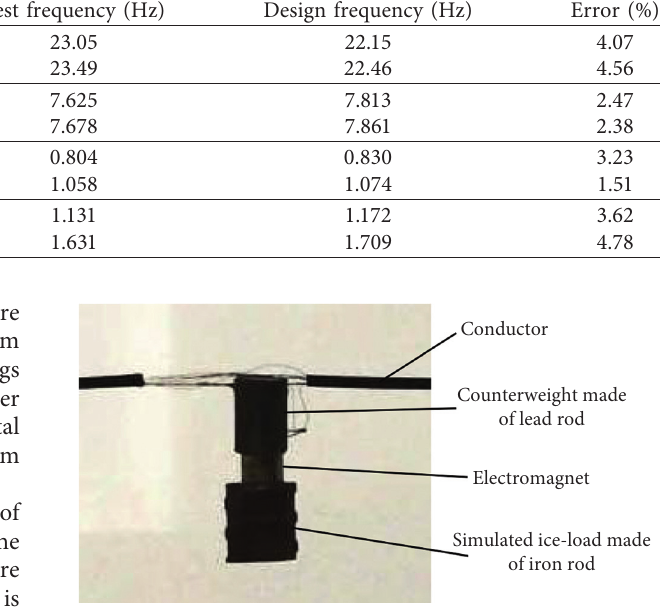
Figure 3: Simulated ice load and control device of ice